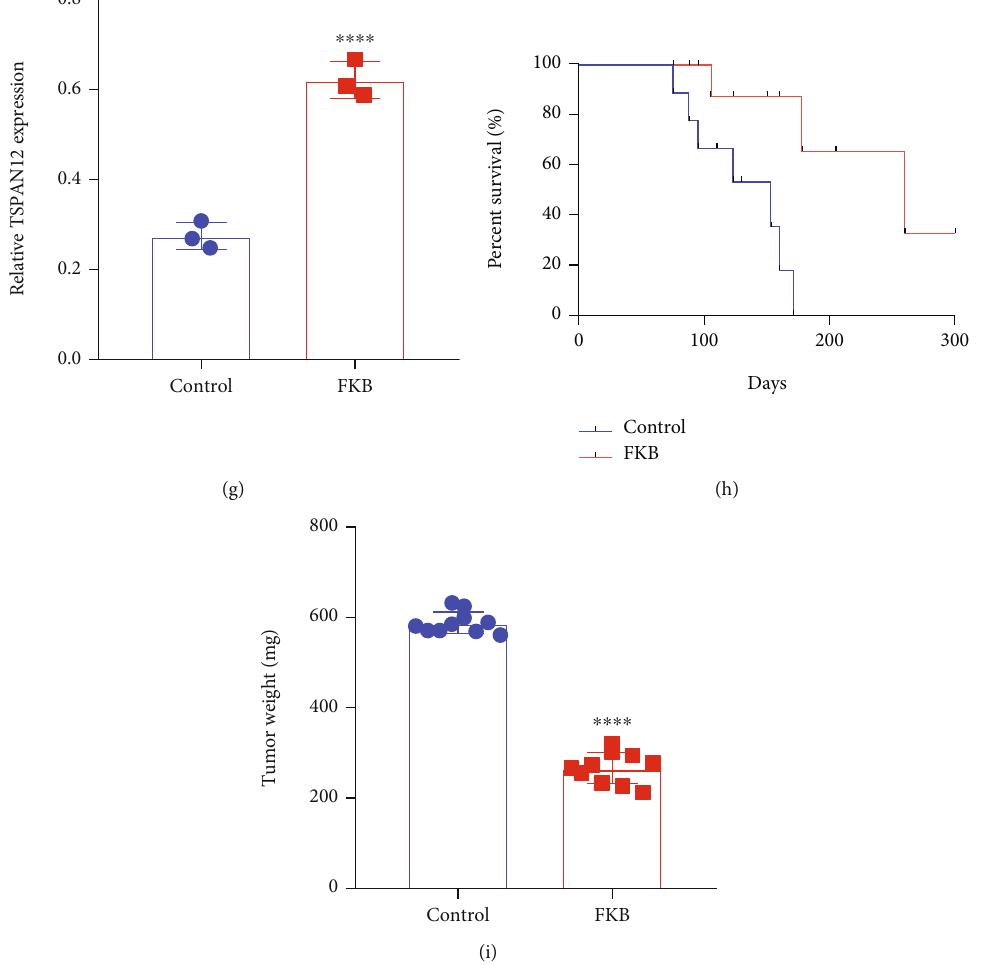
Figure 7: FKB activates TSPAN12 expression and TGF- β 1/SMAD4 pathway in vivo. (a – c) Immunohistochemistry results of TGF- β 1, SMAD4, and TSPAN12 proteins in gastric cancer tissues of FKB treatment and control groups. Bar = 20 μ m . (d) Representative images of western blot. (e – g) TGF- β 1, SMAD4, and TSPAN12 expression was examined in gastric cancer tissues of nude mice between FKB treatment and control groups using western blot. (h) FKB treatment prolonged the survival time of nude mice xenografted with SGC-7901 cells. (i) FKB treatment lowered the tumor weight of nude mice xenografted with SGC-7901 cells. ∗∗∗∗ p < 0 : 0001